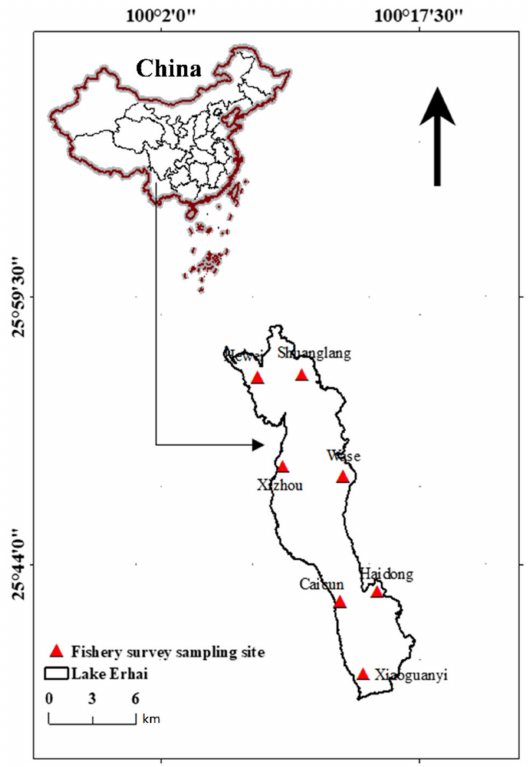
Figure 1. Location of Lake Erhai and its sampling